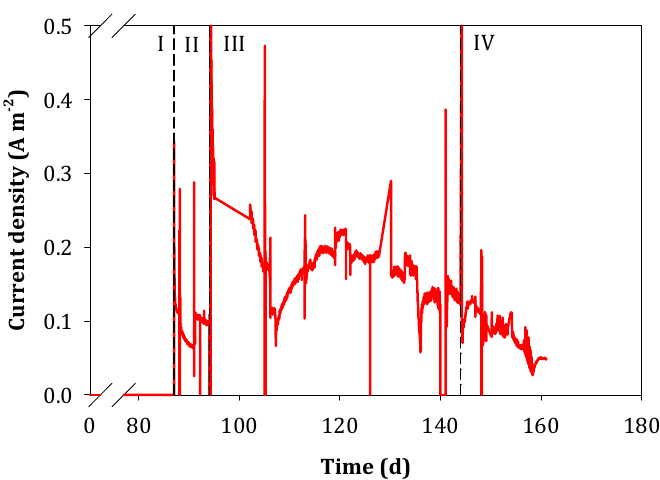
Figure 5. Current density of the FC during all the experimental phases. N.B. The start-up and period I are condensed because the FC was in open circuit during this time (no current).